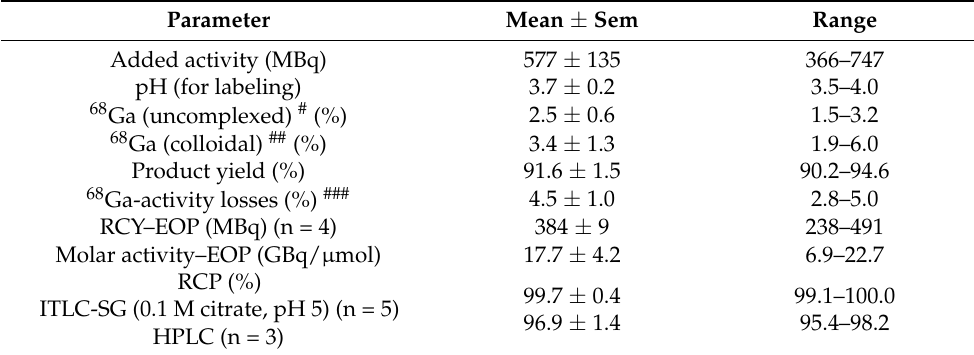
Table 2. Quantitative, kit-like [ 68 Ga]Ga-DOTA-[Thi 8 , Met(O 2 ) 11 ]SP preparation.